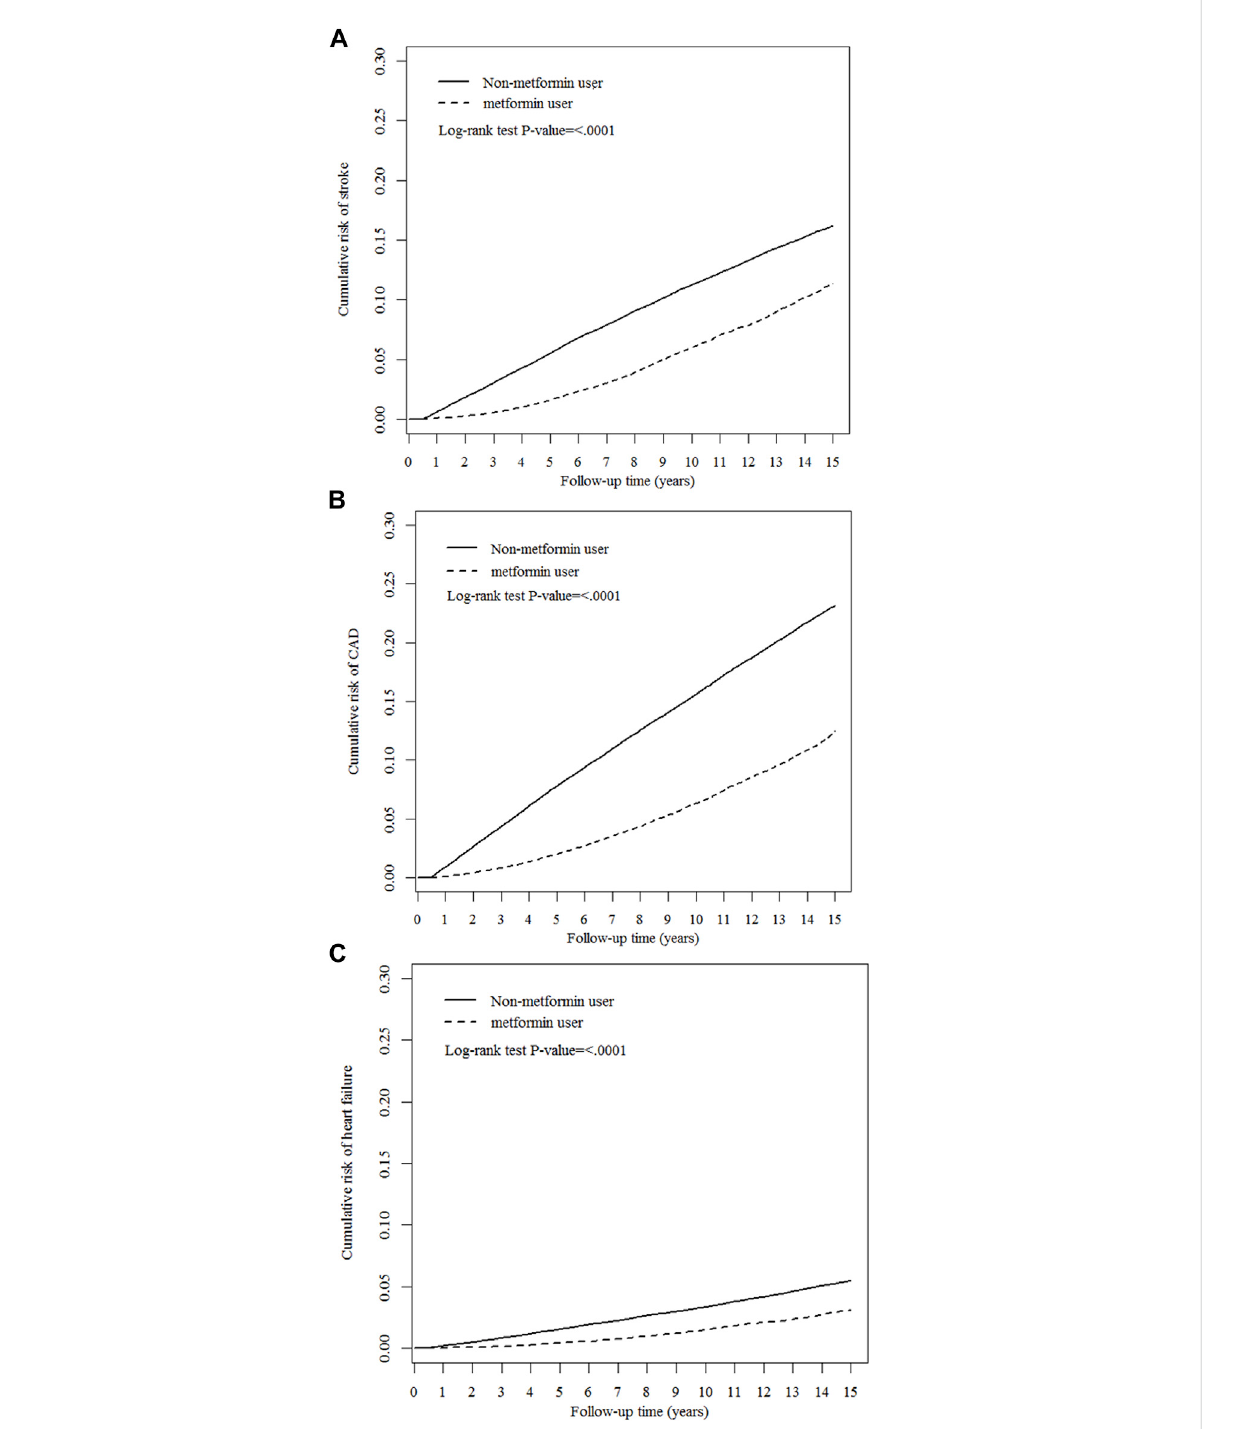
FIGURE 3 Cumulative risks of cardiovascular events between metformin users and nonusers. (A) stroke, (B) coronary artery disease (CAD), and (C) heart